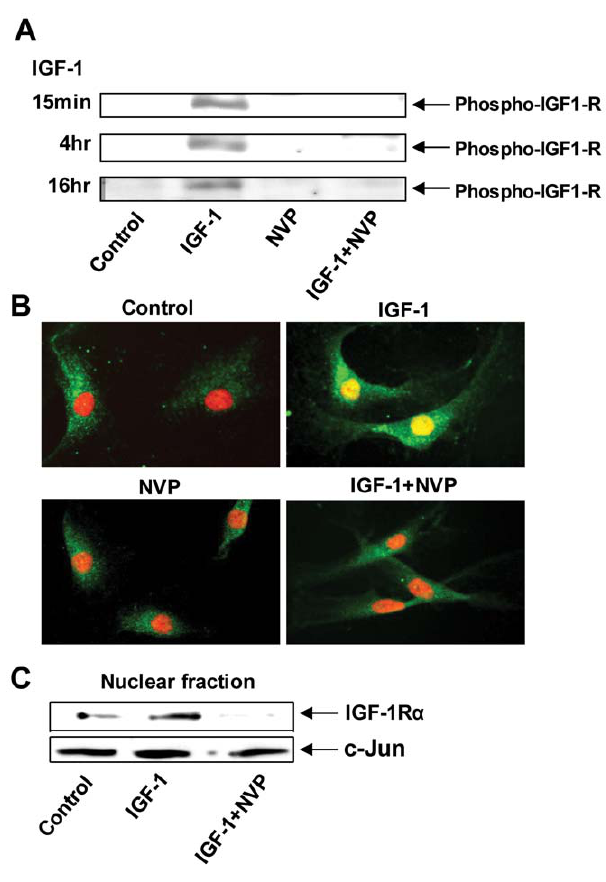
Figure 3. IGF-1R b phosphorylation may play an essential role in the nuclear translocation of IGF-1R a in GD orbital fibroblasts. ( A ) NVP-AEW-541, a specific tyrosine kinase inhibitor blocks IGF-1R phosphorylation ( B ) NVP-AEW-541 blocks nuclear IGF-1R a accumula- tion. GD orbital fibroblasts were treated as indicated and stained with anti-IGF-1R a Ab (green) and counterstained with PI. ( C ) Western blot analysis of nuclear proteins from GD orbital fibroblasts treated with nothing, IGF-1, NVP-AEW-541, or the combination and probed with anti- IGF-1R a and anti-c-jun Abs. The findings are representative of three experiments performed.